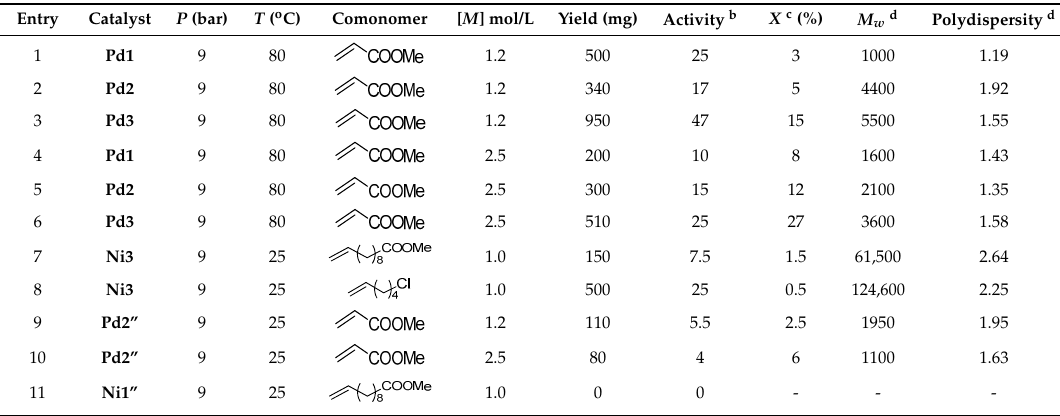
Table 2. Ethylene copolymerization catalyzed by Pd(II) and Ni(II) complexes a . Entry Catalyst P (bar) T ( o C) Comonomer